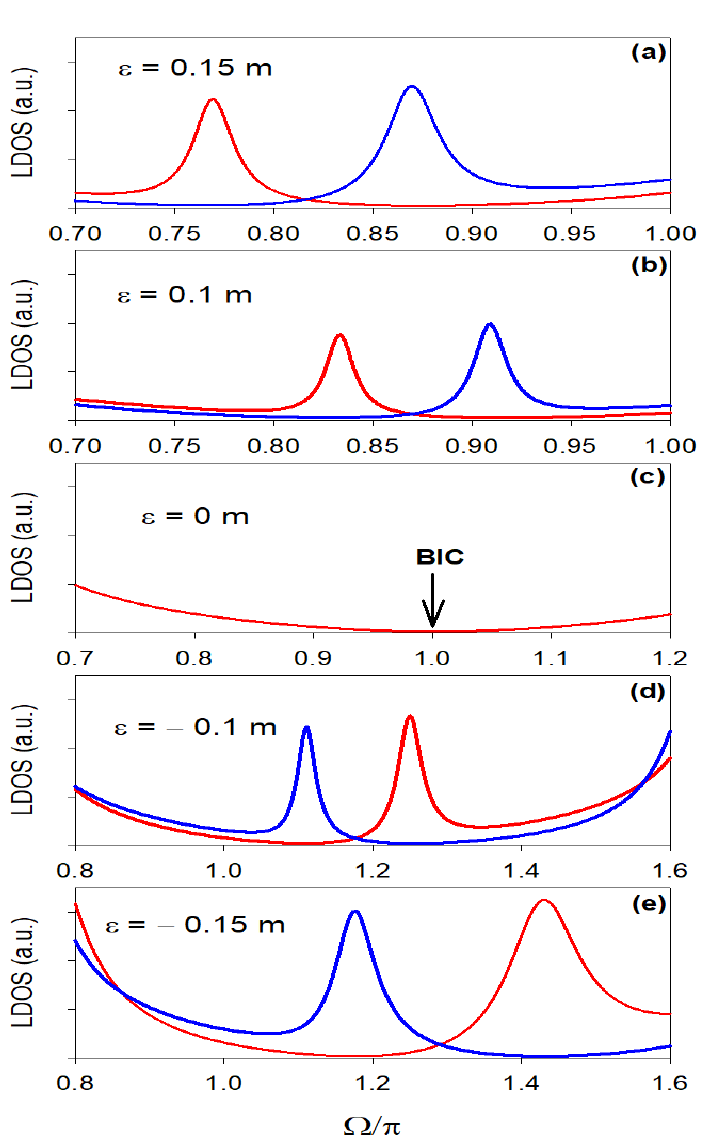
Figure 6. Local density of states (LDOS) as function of dimensionless frequency for different value of ε . Blue and red curves correspond to LDOS in the first and second outputs respectively. The arrow in ( c ) indicates the position of BIC